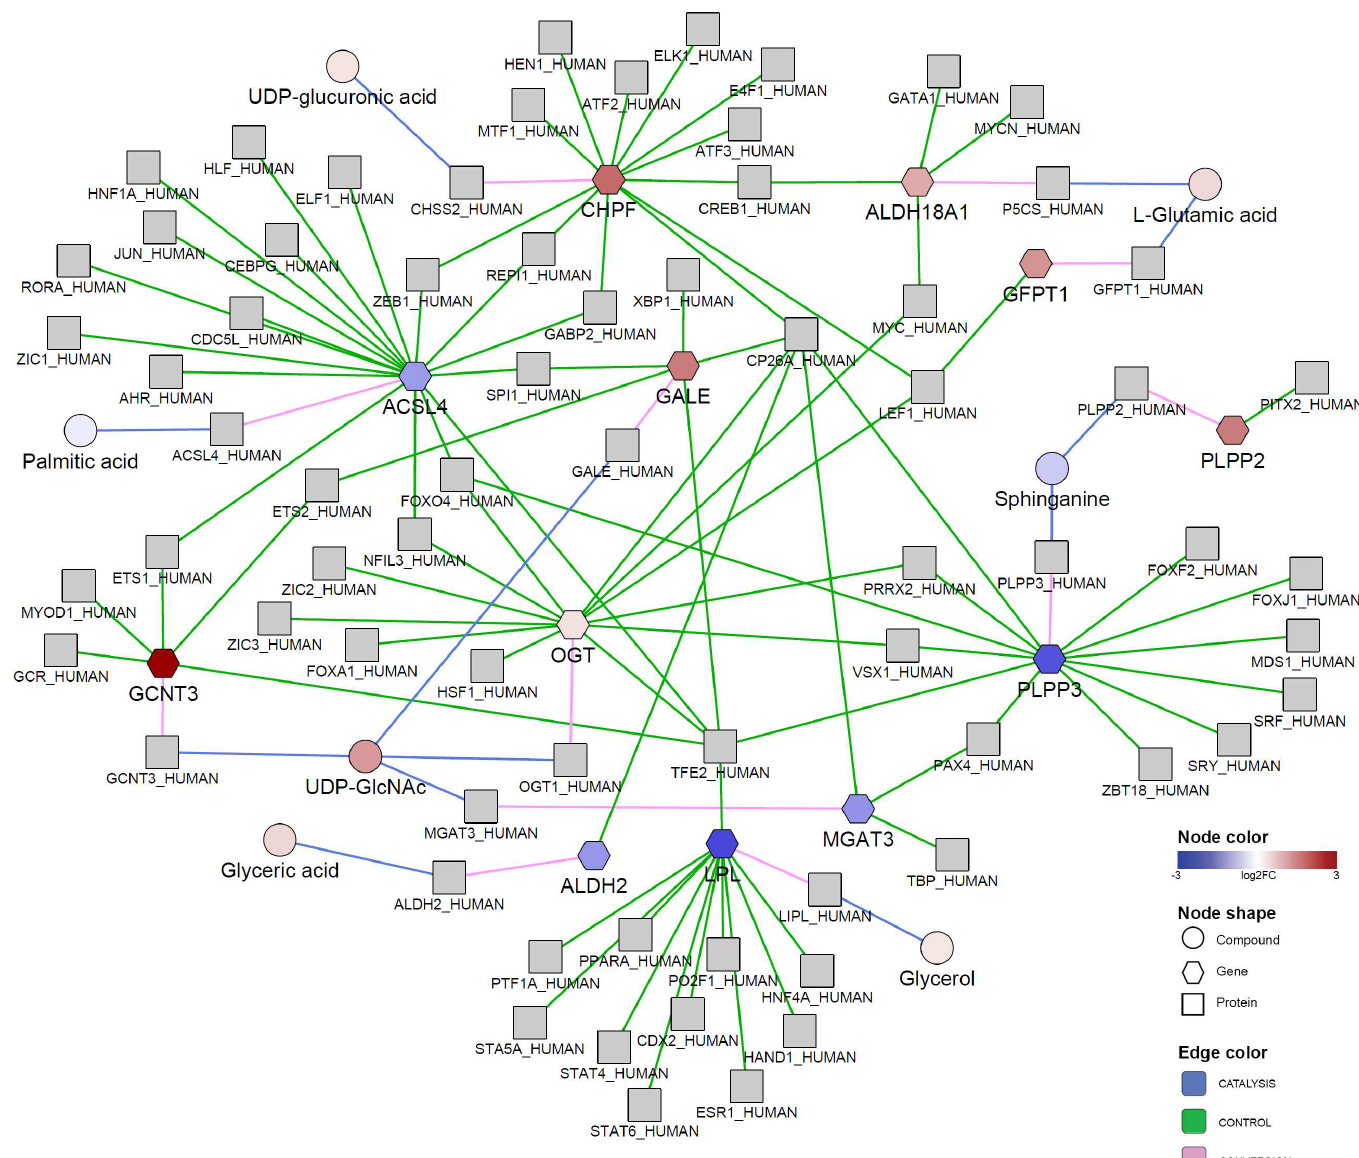
Fig 3. Biological network integrating significant differences in gene and metabolite regulation in lung adenocarcinoma compared to paired control tissues. Significantlydifferent genes and metabolites were mappedonto the metabox internalgraph databaseusing enzymes as linkingnodes (grey). The resulting network was downloaded and mapped relativechanges betweentumor and non-tumor tissues using Cytoscape. Graph relationships CONTROL, CONVERSION, and CATALYSIS are labeledby colored edges. The network shows metaboliclinks betweenglycerol,palmitic acid, sphinganine, glutamic acid, glyceric acid, UDP-glucuronic acid and